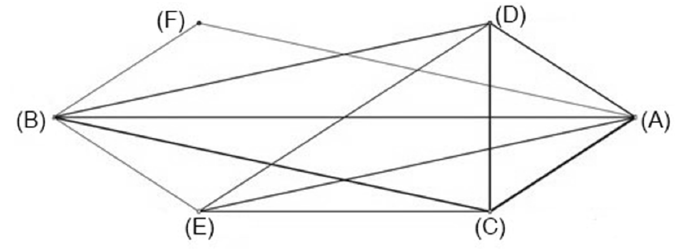
Figure 7. Spider chart of various types of compensation.